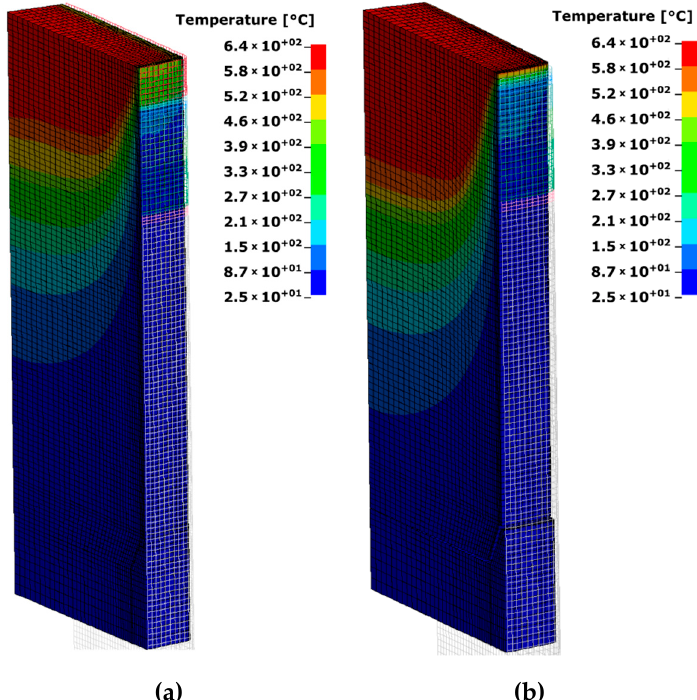
Figure 5. Comparison of temperature results between; ( a ) BT; and ( b ) DMT for 1.4 m billet length.